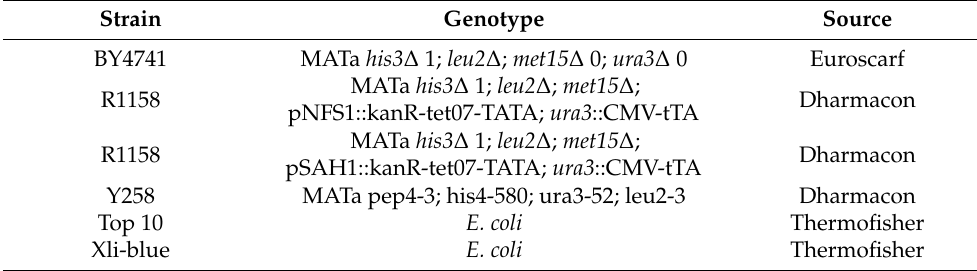
Table 2. S. cerevisiae and bacterial strains.